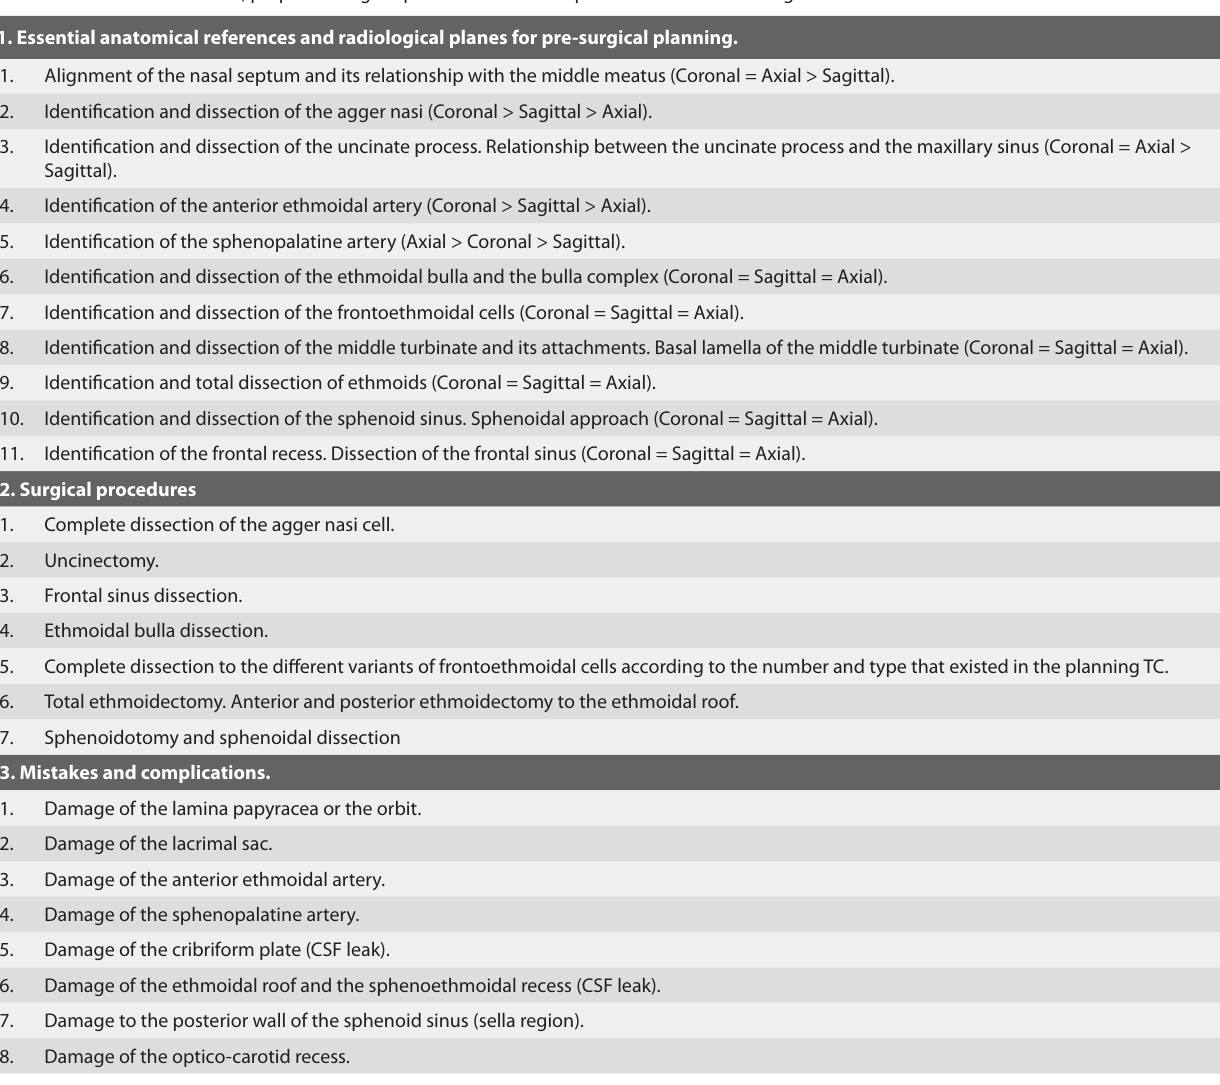
Table 1. Anatomical references, proposed surgical procedures and complications detected during